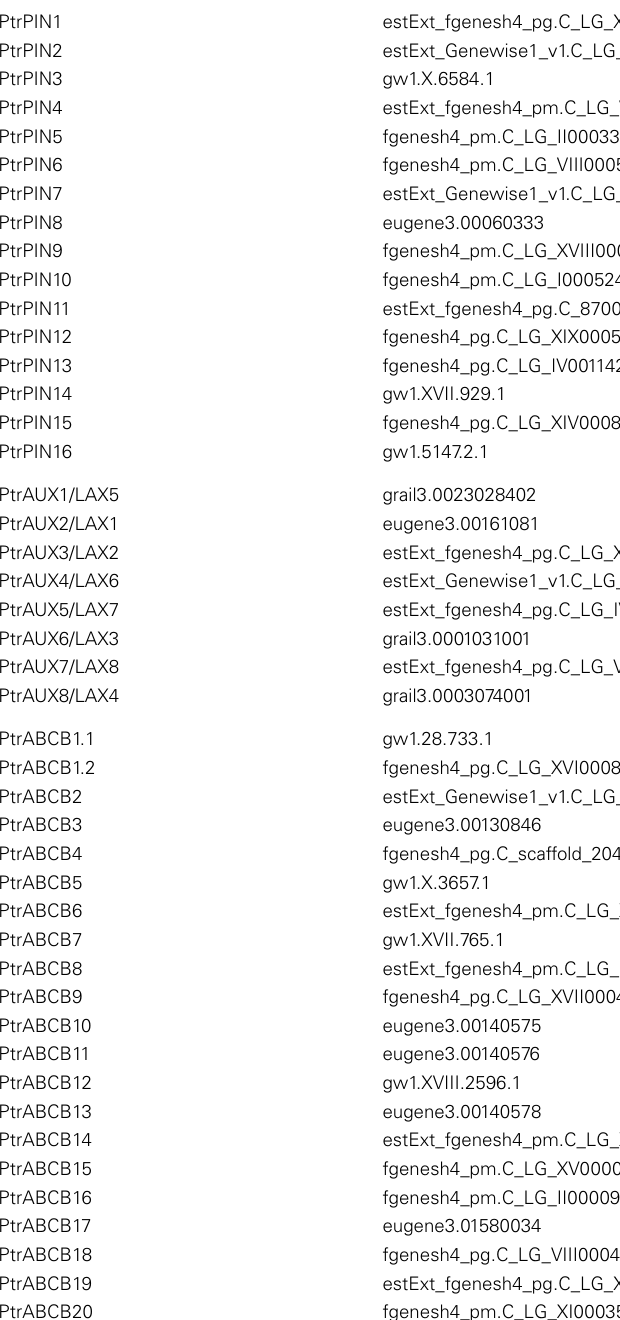
TableA2 | List of putative auxin transport genes identified in the Populus trichocarpa genome.